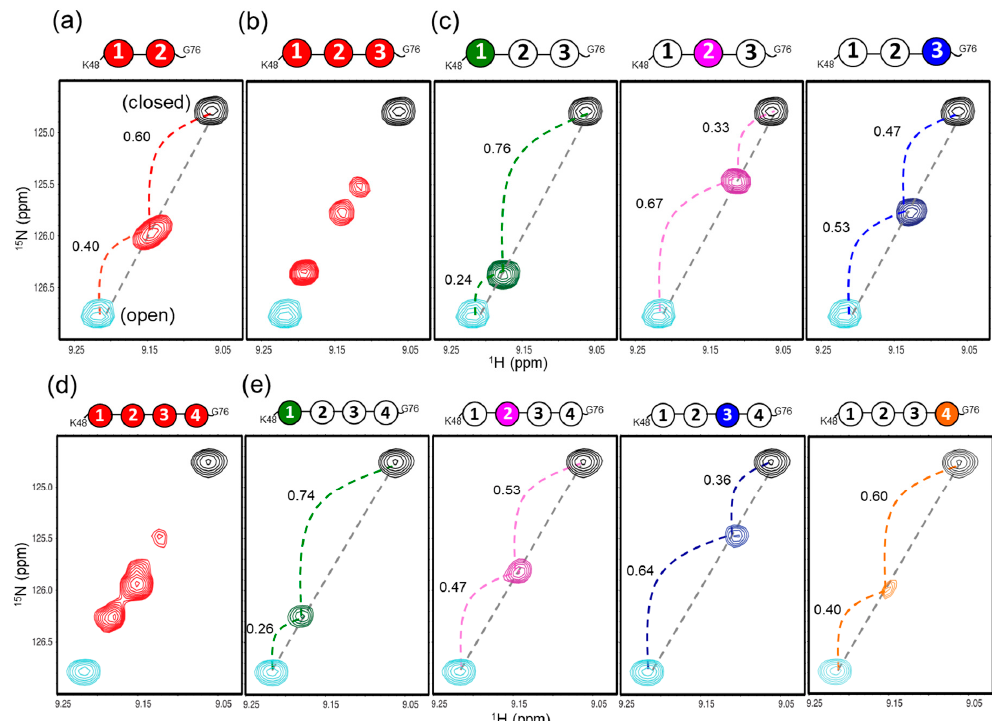
Figure 5. 1 H- 15 N HSQC peaks originating from Val70 of ( a ) uniformly 15 N-labeled n-diUb (red), ( b ) uniformly 15 N-labeled n-triUb (red), ( c ) unit-selectively 15 N-labeled n-triUb chains at the distal Ub1 (green), the middle Ub2 (magenta) and the proximal Ub3 (blue), ( d ) uniformly 15 N-labeled n-tetraUb (red), and ( e ) unit-selectively 15 N-labeled n-tetraUb at the distal Ub1 (green), the middle Ub2 (magenta), the middle Ub3 (blue), and the proximal Ub4 (orange). The peaks from the monomeric Ub (open form) and c-diUb (closed form) are plotted in cyan and black, respectively. The dividing ratios of the chemical shift differences of n-diUb, n-triUb, and n-tetraUb are indicated between monomeric Ub and c-diUb.